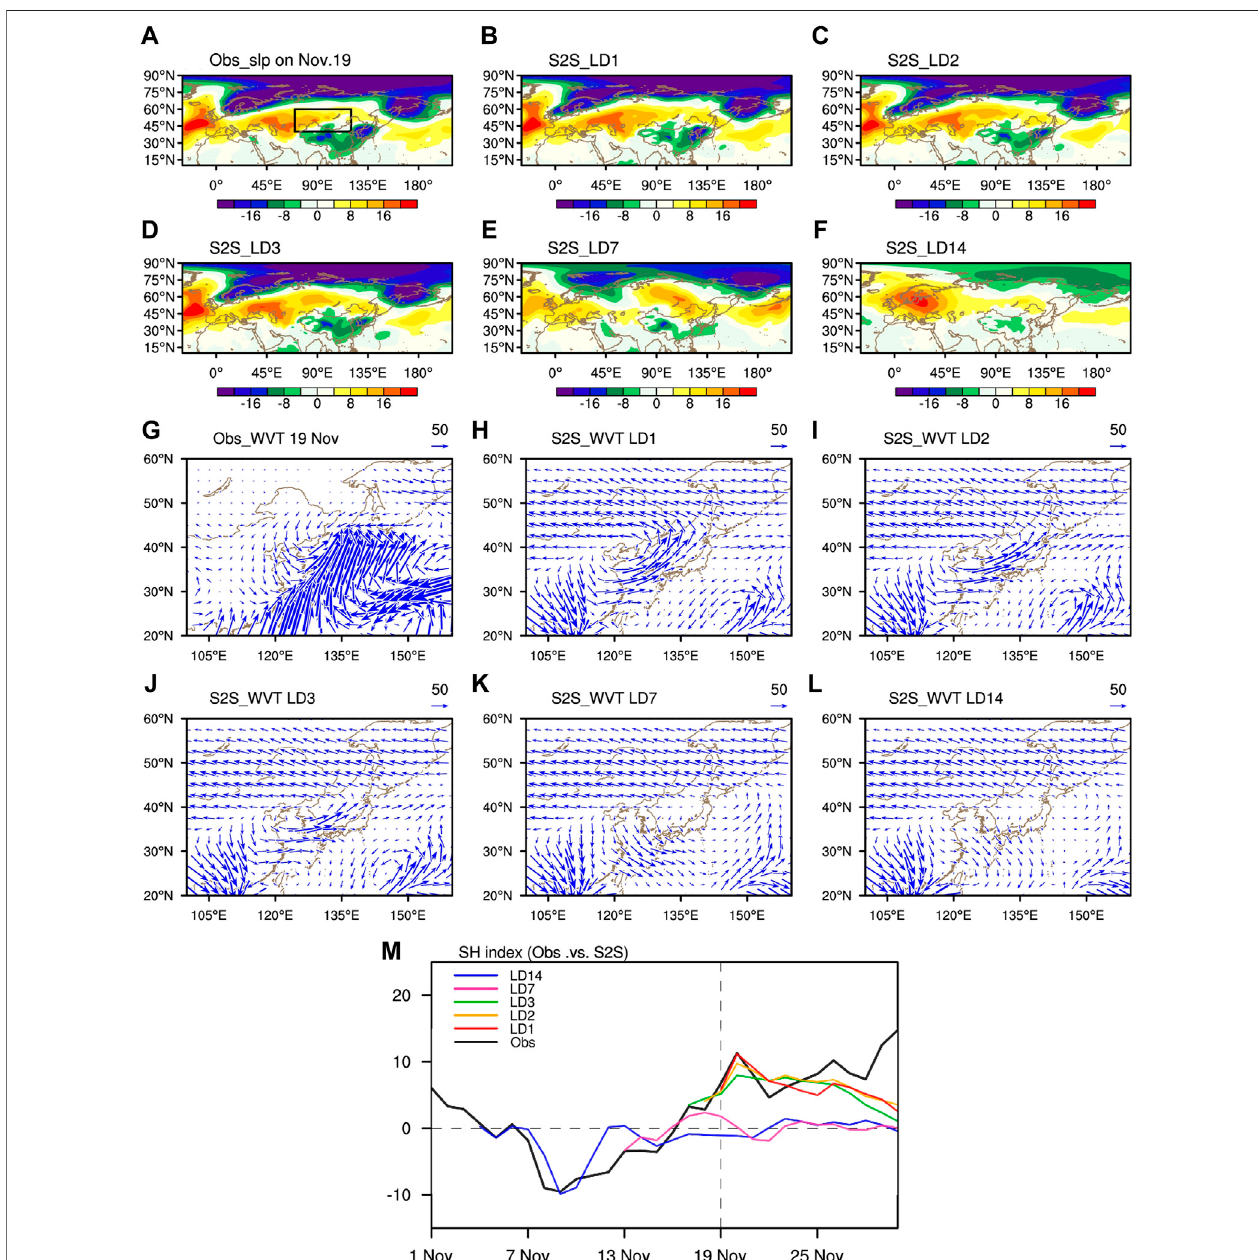
FIGURE 12 | The (A) observed SLP (unit: hPa) during 19 November 2020 and (B – F) forecast ensemble mean SLP of 16 members for lead times of (B) 1 day, (C) 2 days, (D) 3 days, (E) 7 days, and (F) 14 days. Black rectangles indicate the averaging area for the Siberian high index. (G – L) As in (A – F) but for the anomalous WVT. (M) temporal evolution of the Siberian high index in November 2020 (black solid curve) and the predicted results with different leads.